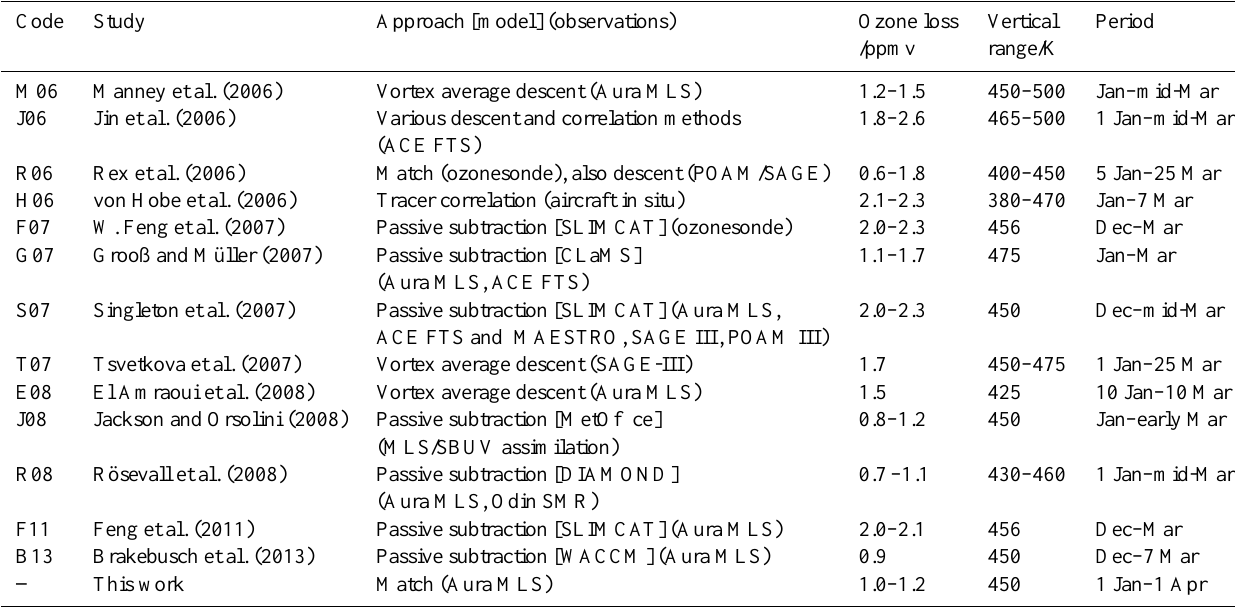
Table 1. Previous quantifications of ozone loss during the 2004/05 Arctic winter.